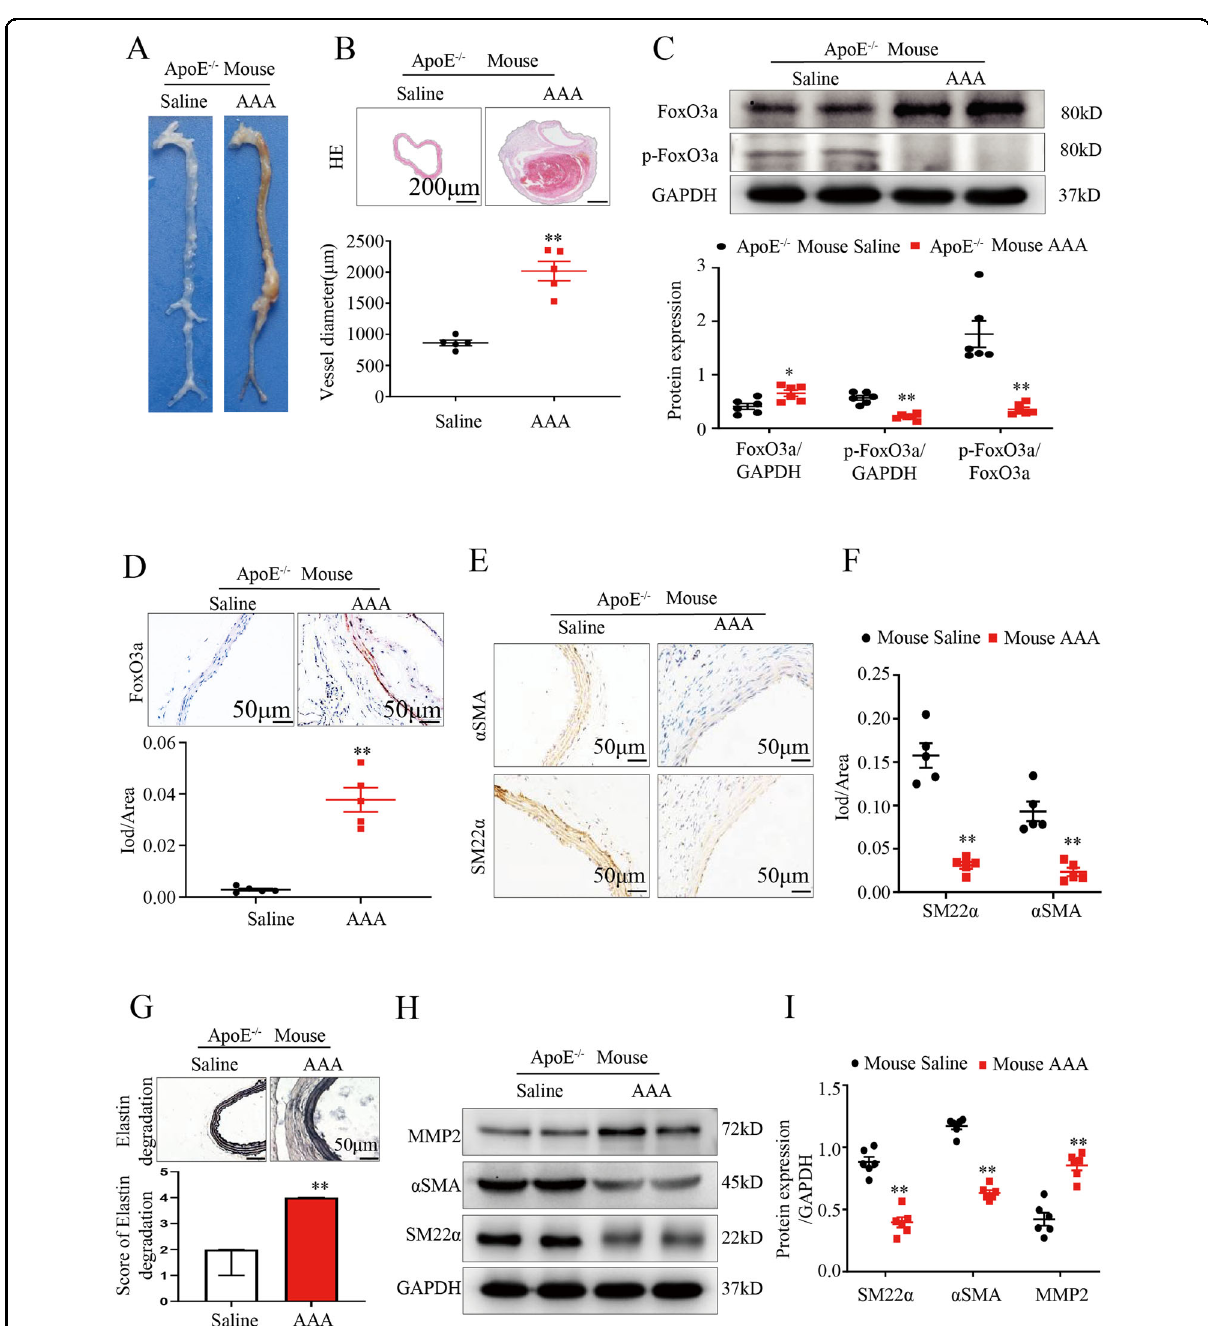
Fig. 2 FoxO3a is upregulated in the aneurysm tissues of apolipoprotein E – de fi cient (ApoE − / − ) mice induced by angiotensin II (Ang II) and the VSMC phenotypic switch occurs during AAA formation. A Representative photographs showing the macroscopic features of aortic aneurysms at 28 d after Ang II infusion in male ApoE − / − mice. B Representative pictures of aorta cross-sections stained with hematoxylin-eosin (scale bar = 200 μ m) and the vessel diameter ( μ m) in aortic aneurysms (AAs) from Ang II-induced male ApoE − / − mice and control male ApoE − / − mice ( n = 5). C WB and densitometric analysis of the protein levels of FoxO3a and p-FoxO3a in AAs from Ang II-induced male ApoE − / − mice and control male ApoE − / − mice (male; n = 6). D FoxO3a immunohistochemical staining of the aortas in AAs from Ang II-induced male ApoE − / − mice and control male ApoE − / − mice (scale bar = 50 μ m; n = 5). E and F Representative immunohistochemical staining of α -SMA and SM22 α in suprarenal AAs from male ApoE − / − mice treated with Ang II and control male ApoE − / − mice (scale bar = 50 μ m; n = 5). G Representative staining of elastin in the abdominal aortas of angiotensin-infused male ApoE − / − mice ( n = 15). H and I WB and densitometric analysis of the protein levels of α -SMA, MMP2 and SM22 α in the AAs of Ang II-induced male ApoE − / − mice and control male ApoE − / − mice ( n = 6). Data are presented as the mean ± SE. * p < 0.05, ** p < 0.01. Saline indicates control male ApoE − / −